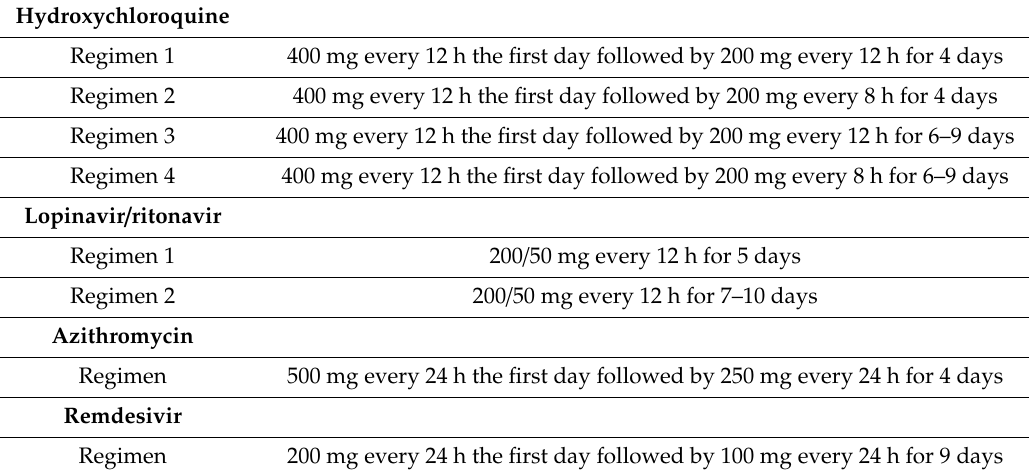
Table 1. Dosage and durations of antiviral treatment for coronavirus disease 2019.